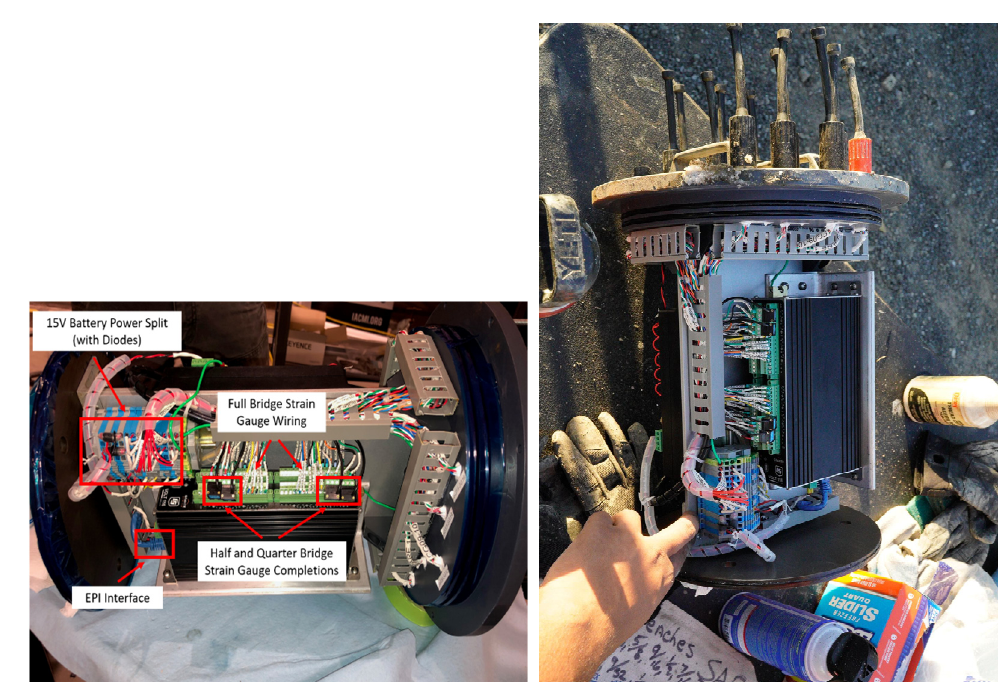
Figure 7. The Campbell Scientific Volt 116 data logger mounted in the canister with strain gage wiring ( left ) before deployment and ( right ) after deployment. The power terminal block can be seen next to the ADC.